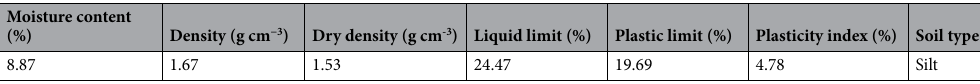
Table 1. Basic physical properties of soil in the test area.